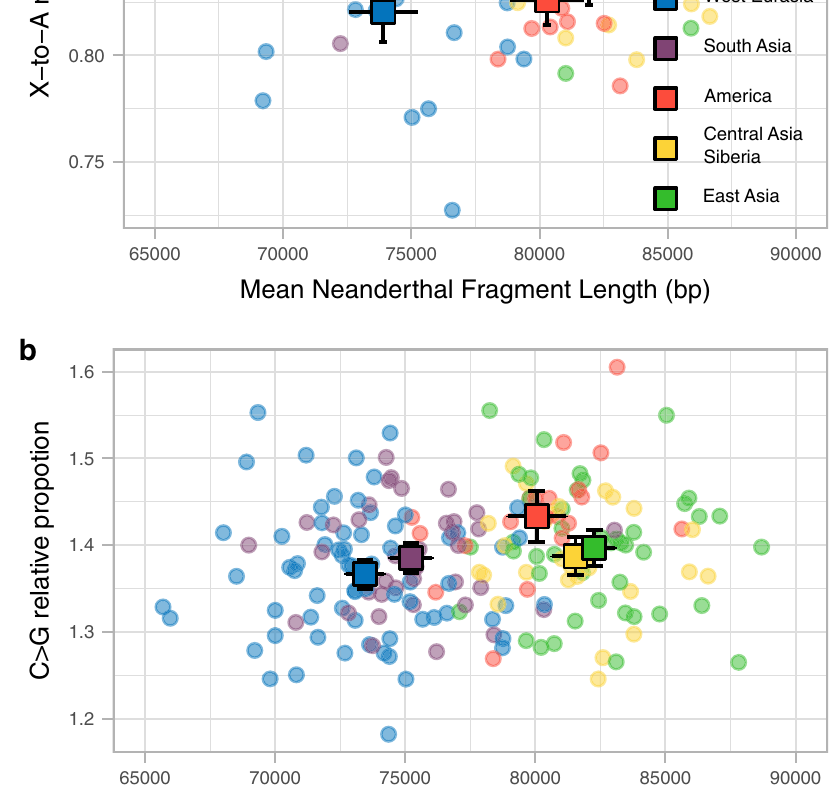
Fig. 4 Sex-speci fi c mutation patterns. a Scatterplot of the X-to-A ratio in derived allele accumulation ( y -axis, Methods) and the mean archaic fragment length ( x -axis) for each region (colour coded). Each dot represents an individual in the corresponding population. The mean for each population for each axis is shown in squares and their 95%CI are denoted by the error bars. Only females were used to produce this plot. The sample sizes of individuals for each region for which summary statistics are derived, together with other statistics, are indicated in Supplementary Table 12. b The same as in ( a ), but the ratio between the proportions of C > G derived alleles in cDNM and the rest of the genome (Methods). All samples were used to produce this plot. The sample sizes of individuals for each region for which summary statistics are derived from, together with other statistics, are indicated in Supplementary Table 2 and Supplementary Table